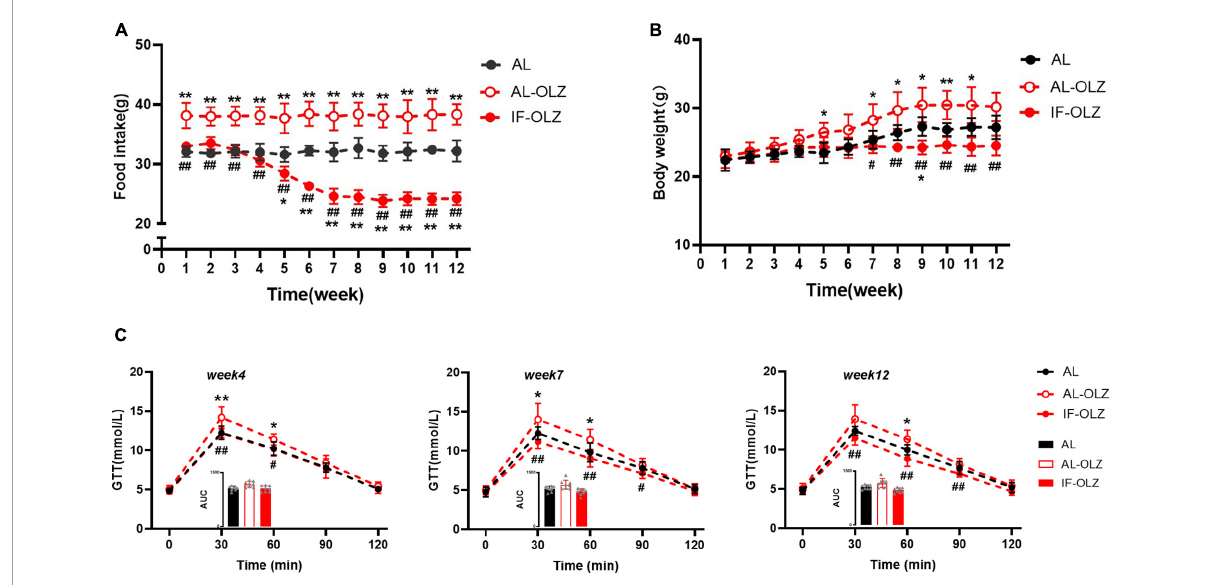
FIGURE4 Grouped data showing the relationship of food consumption, body weight, and glucose homeostasis. (A) Changes in food intake during 12 weeks of IF cycles. (B) Changes in body weight during 12 weeks of IF cycles. (C) GTT at Weeks 4, 7, and 12; the inset shows the area under the curve (AUC). n = 5 in panels (A,B) ; n = 8 in panel (C) . One-way ANOVA followed by Tukey’s test was used for the data analysis. Mean ± SD; * P < 0.05 and ** P < 0.01 vs. AL; # P < 0.05 and ## P < 0.01 vs. AL-OLZ. OLZ, olanzapine.